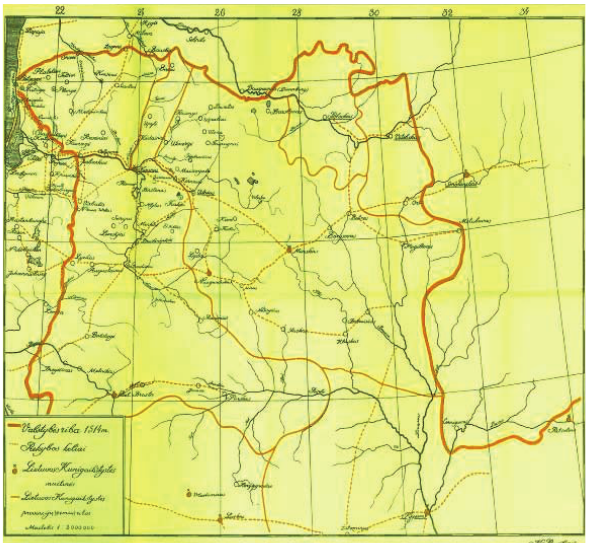
Fig. 16. Trade between Lithuania and Prussia road map, scale 1:2 000 000, by Z.